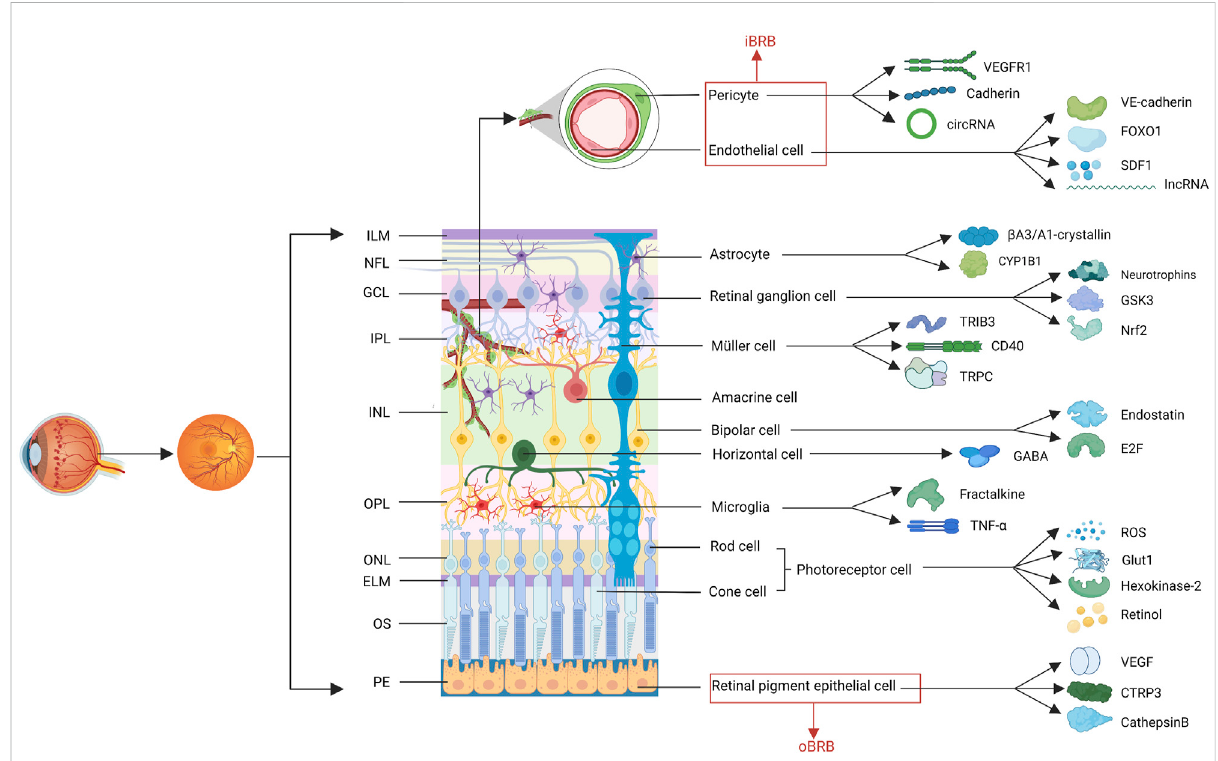
FIGURE 1 The structure of retina. The retina comprises at least 10 distinct layers, including eleven cell types involved in the progress of DR. The factors relatedto thesecells, described inthisreviewareshown. (ILM,internallimiting membranes;NFL, nerve fi berlayer;GCL,ganglioncelllayer;IPL, inner plexiform layer; INL, inner nuclear layer; OPL, outer plexiform layer; ONL, outer nuclear layer; ELM, external limiting membranes; OS, outer segments;PEL,pigmentepitheliumlayer;iBRB,innerblood-retinabarrier;oBRB,outerBRB;VEGF,vascularendothelialgrowthfactor;VEGFR2, VEGF receptor 2; SDF1, stromal cell-derived factor 1; CYP1B1, cytochrome P450 1B1; GSK3, glucogen synthase kinase 3; Nrf2, nuclear factor erythroid 2-related factor; TRIB3, tribbles homolog 3; TRPC, transient receptor potential canonical; GABA, γ -aminobutyric acid; ROS,